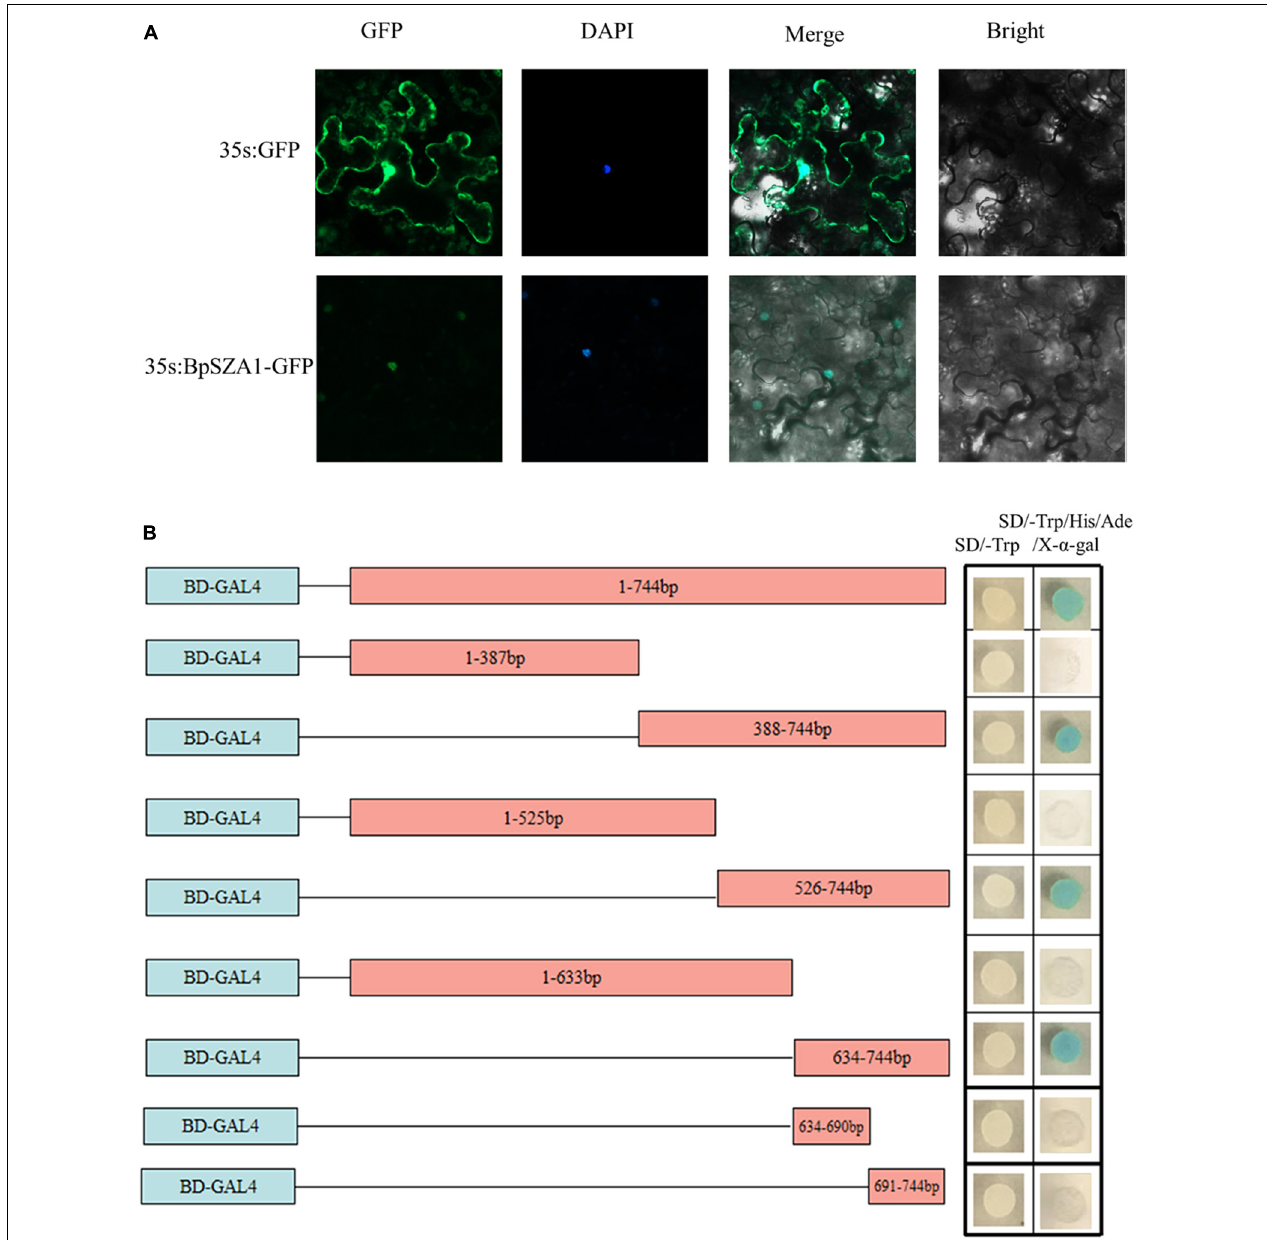
FIGURE 3 | Subcellular localization and transactivation of BpSZA1. (A) Subcellular localization of BpSZA1 in transiently expressed tobacco leaves shows BpSZA1 is targeted to the nucleus. Bars = 50 µ m. (B) Truncated sequences of the CDS of BpSZA1 were fused in-frame, respectively, to the GAL4 DNA-binding domain in pGBKT7 and transformed into Y2H yeast cells. The transformed cells were plated onto SD/-Trp (growth control) or SD/-Trp/-His/-Ade/X-a-Gal medium. pGBKT7 empty vector was used as a